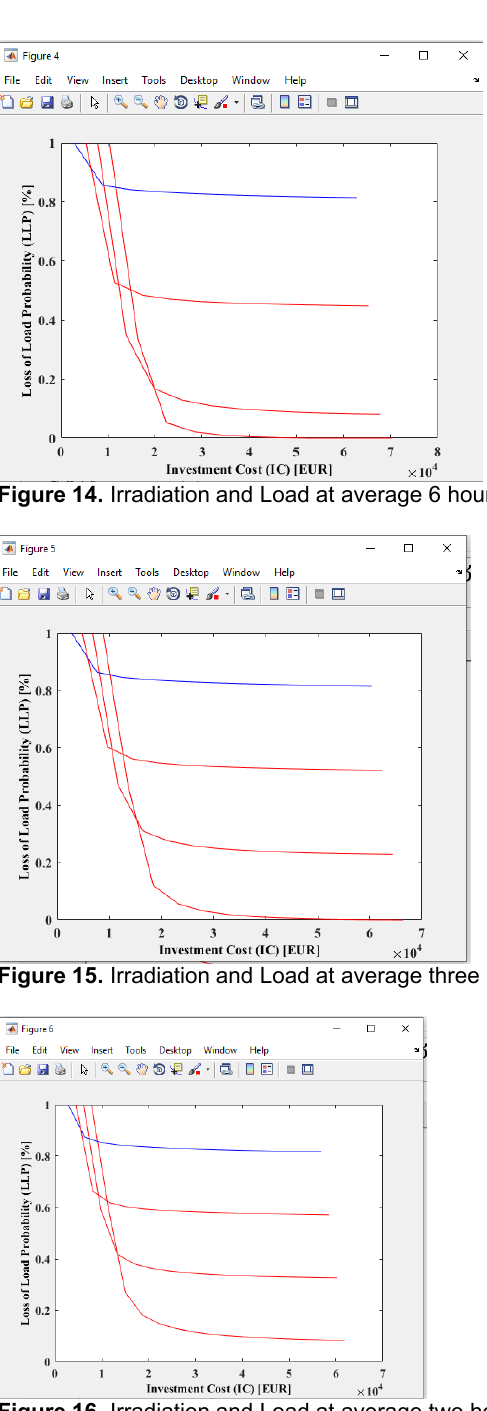
Figure 16. Irradiation and Load at average two